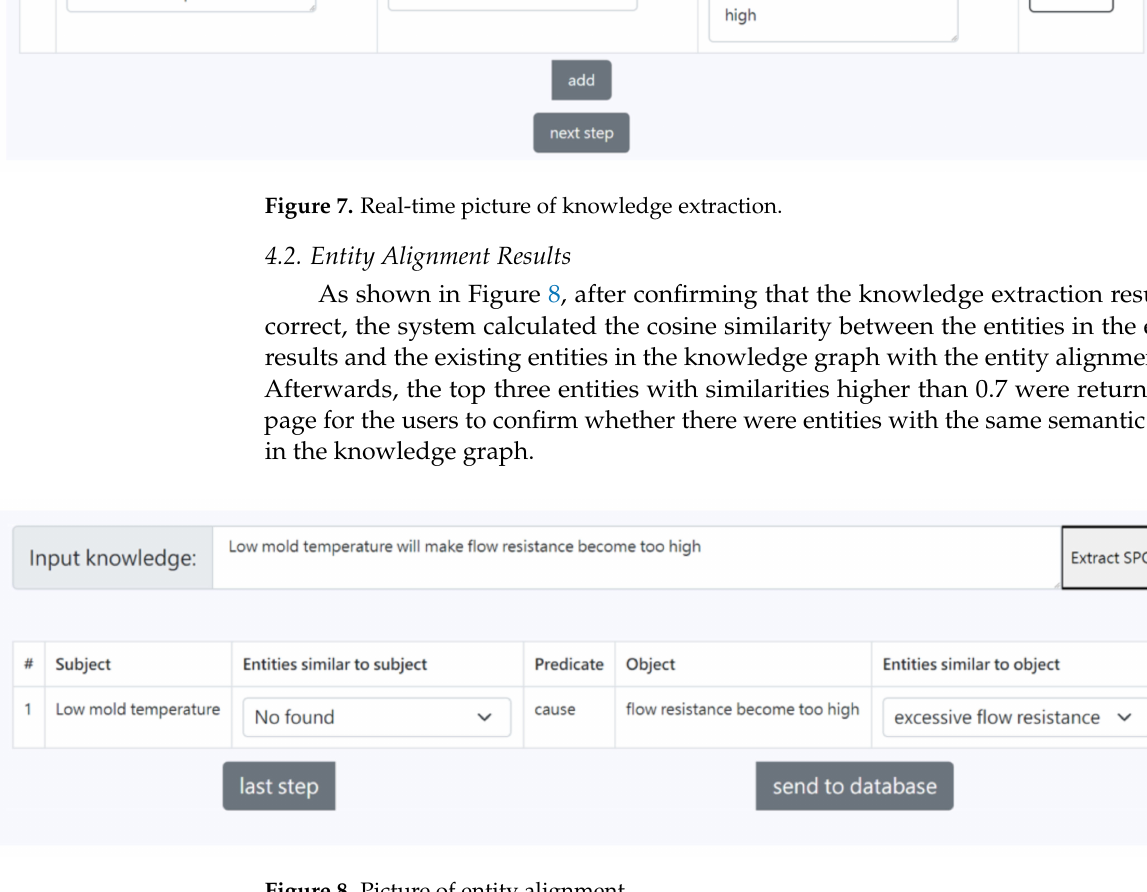
Figure 8. Picture of entity